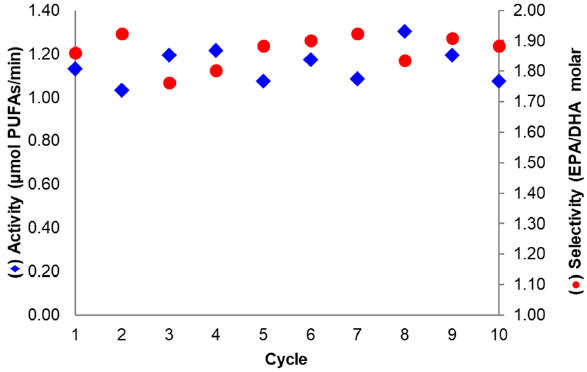
• ) after successive reaction